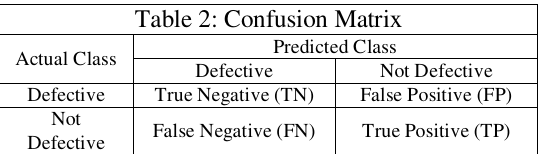
Table 2: Confusion